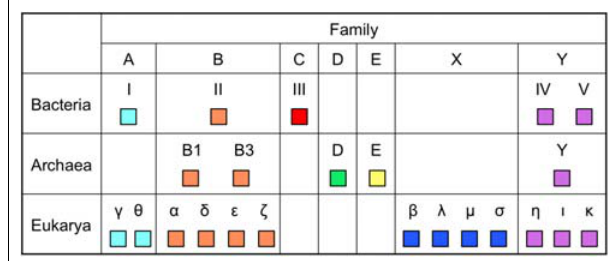
FIGURE 2 | Distribution of DNA polymerases in the three domains of life. The names of DNA polymerases vary, depending on the domains. Only DNA polymerases with in vitro activity, if applicable, are shown. Eukaryotic Pol γ is from mitochondria and archaeal PolE is a plasmid-encoded